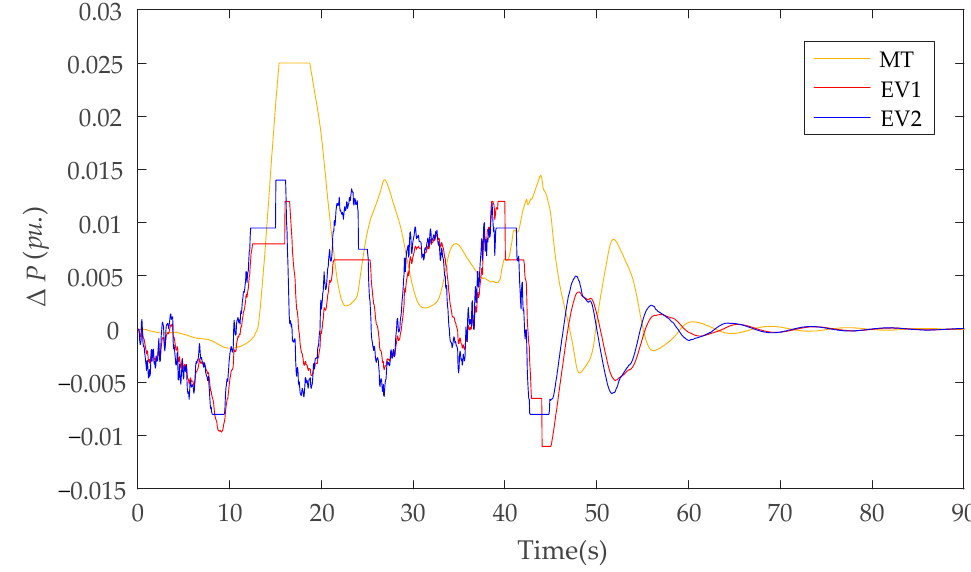
Figure 14. Power variations of each equipment under wind power disturbance.